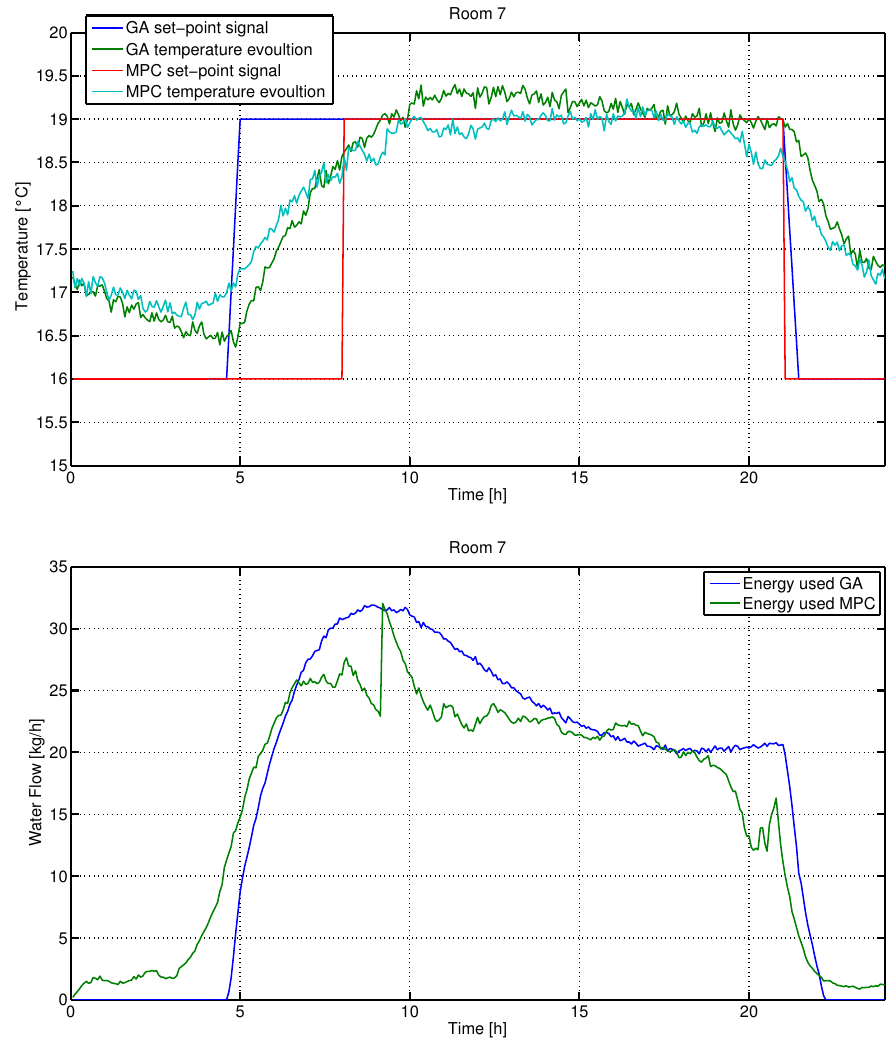
Figure 16. One day simulation, 10 December, for room 7 (ARMAX model). Top : user defined set point ˜ T i (red line), optimized set-point ramp signal ¯ T i (blue line), temperature evolution T i in case of genetic algorithm set-point signal (green line), temperature evolution T i in case of MPC (light blue line). Bottom : resulting inlet water flow in case of ramp set-point signal (blue line) and in case of MPC (green line). Table 9. Performance index value (4) for each room when both the genetic-based optimization and MPC are applied to the system. In this case, the GA optimization is based on the weather conditions of the day before (December 9) while the MPC uses the weather condition of the day after (10 December)).